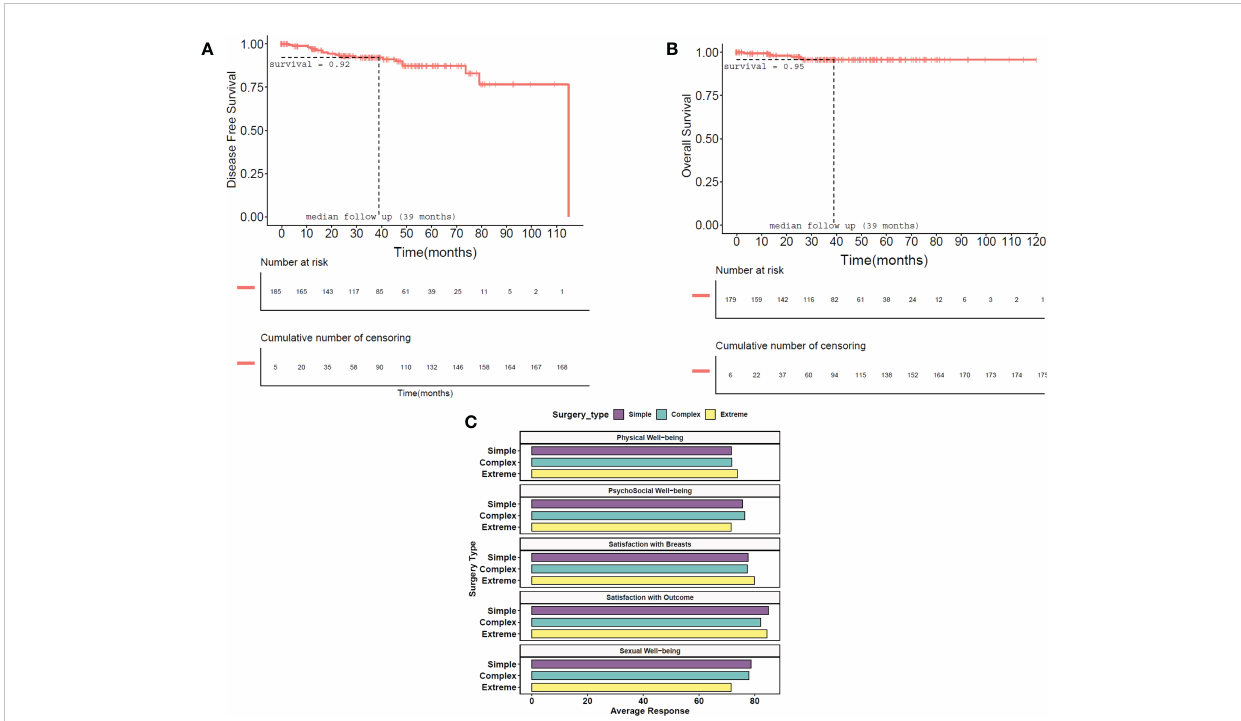
FIGURE 4 Survival Kaplan – Meir plots of disease-free and overall survival. (A) In disease-free survival, local and distant recurrences and metastasis are taken as events. Time is the time period in months between surgery and the known date of evidence of recurrence and is shown in months. The probability of a patient being disease-free at median follow-up (39 months) is 92.2%. (B) In overall survival, the approximate date of death due to any cause was taken as an event. Time is the time period in months between surgery and the approximate cause of death and is shown in months. The probability of survival at median follow-up (39 months) is 95.9%. Vertical bars indicate censored patients in both plots. (C) PROM scores according to TM surgery type represented graphically. Overall PROM scores are presented in the table. PROM, patient-reported outcome measure; TM, therapeutic mammoplasty.